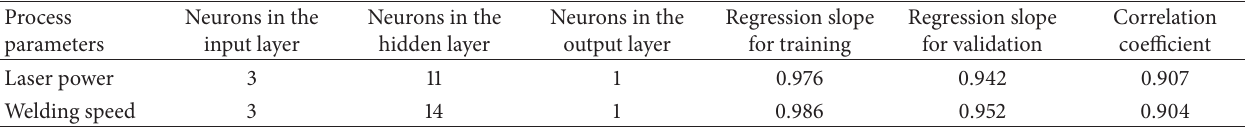
Table 5: Neural network architecture and performance for the reverse approach.